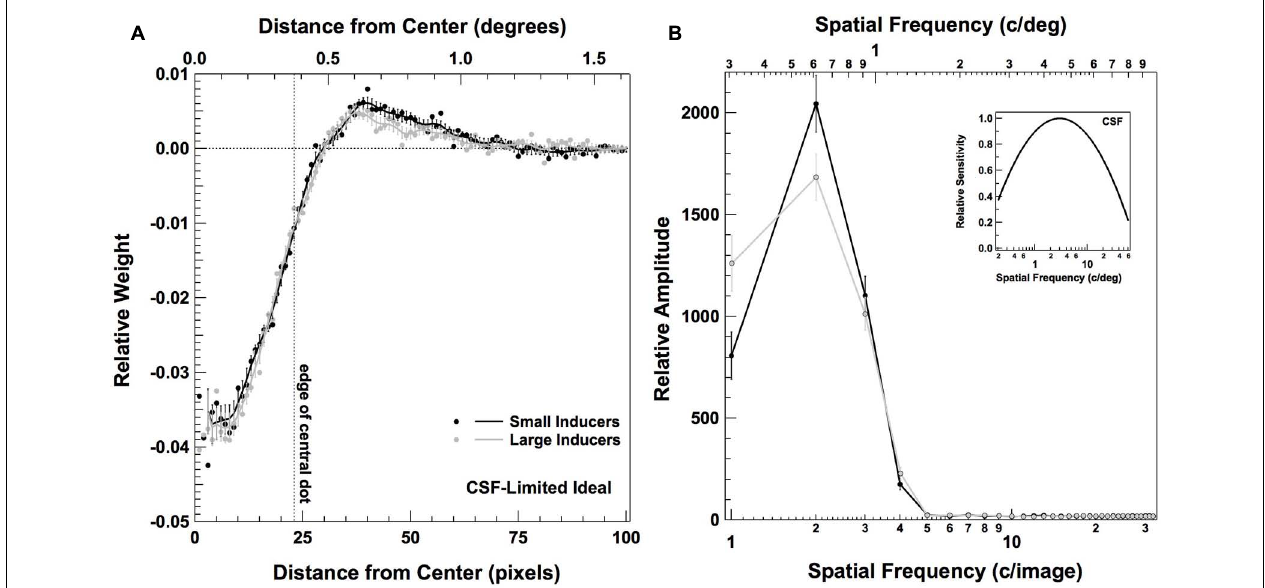
FIGURE 7 | Classification images for a CSF-limited ideal observer in Experiment 2. Panel (A) plots the radially averaged classification image, as described in Figure 5 ; panel (B) plots the frequency domain representation of